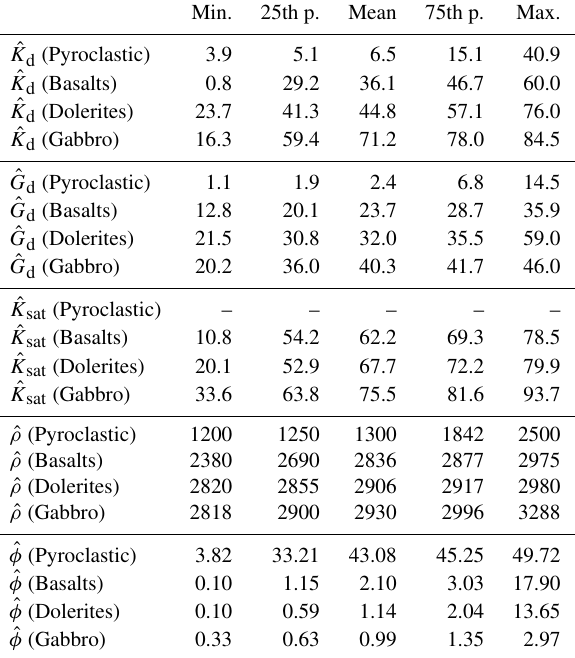
Table 2. Intact-rock properties sorted by lithology listed for the mean value (Mean), the minimum and maximum outliers (Min., Max.), and the 25th and 75th percentiles (25th p., 75th p.). Elas- tic moduli ˆ K d , ˆ K sat , and ˆ G d are in GPa, bulk density ˆ ρ b in kgm − 3 , and porosity ˆ φ in %.